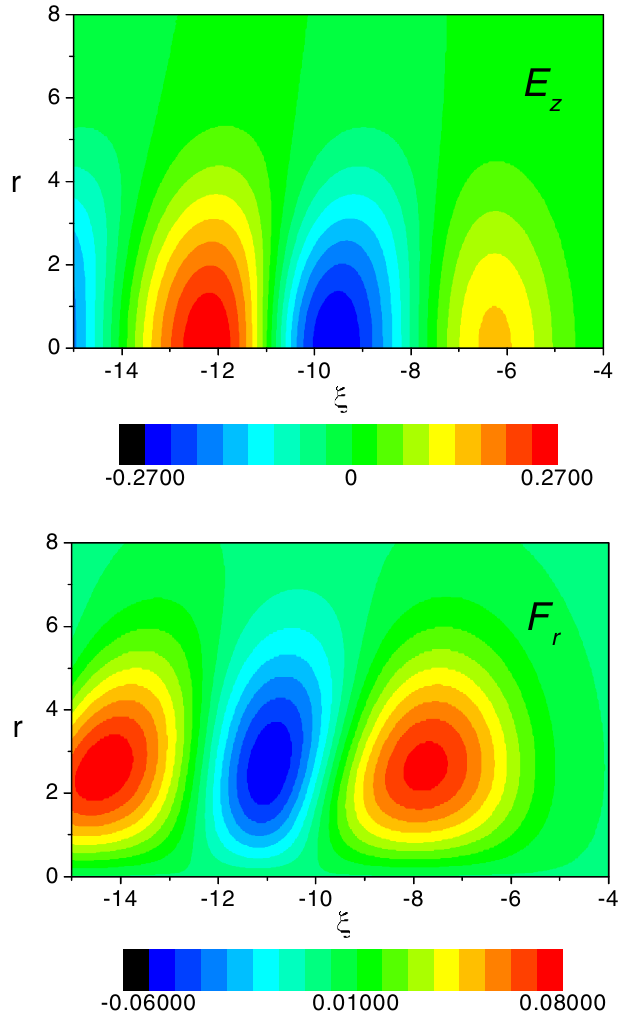
FIG. 1. (Color) The longitudinal ( E ponents of the channel-guided laser wakefield generated by a Gaussian laser pulse. The laser pulse (not shown) is centered at (cid:6) (cid:1) (cid:2) 6 and travels to the right. In this case (cid:7) (cid:1) 2 , w (cid:1) 5 , and (cid:1) 0 : 9 a 0